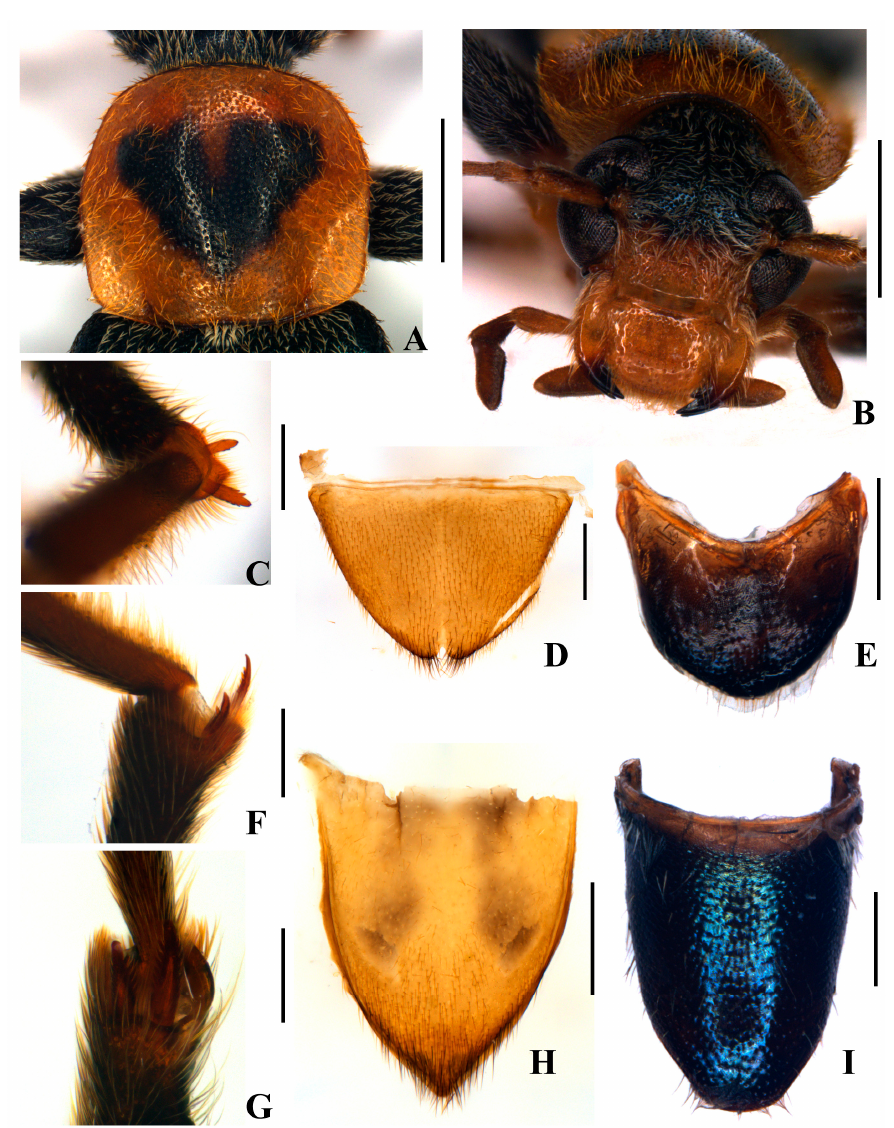
Figure 2. Osphya sinensis sp. n. ( A – C , E – G , I ) male; ( D , H ) female: ( A ) pronotum, dorsal view; ( B ) head, frontal view; ( C ) protibial spurs, dorsal view; ( D , E ) abdominal ventrite V, ventral view; ( F ) mesotibial spurs, lateral view; ( G ) metatibial spurs, dorsal view; ( H , I ) abdominal tergite V, dorsal view. Scale bars ( A , B ) 1.0 mm; ( D – E , H , I ) 0.5 mm; ( C , F , G ) 0.2